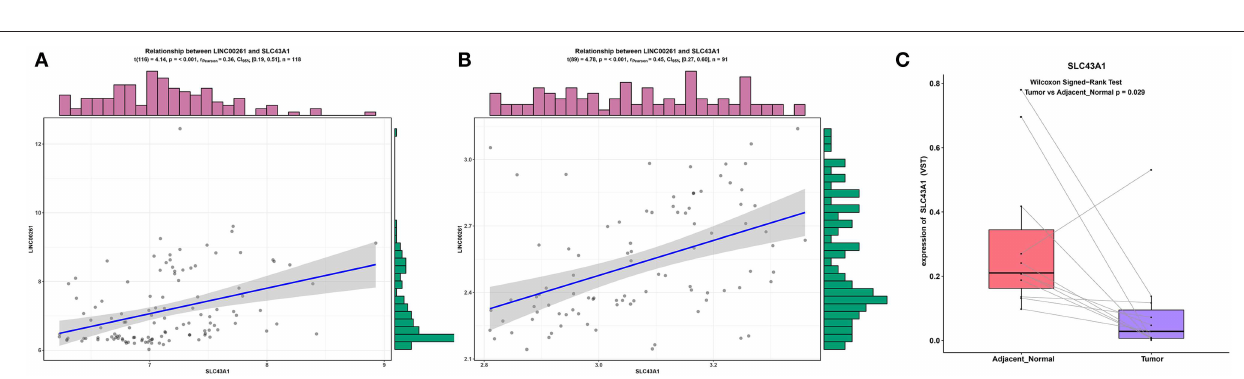
lncRNA-miRNA-mRNA ceRNA network mediated by